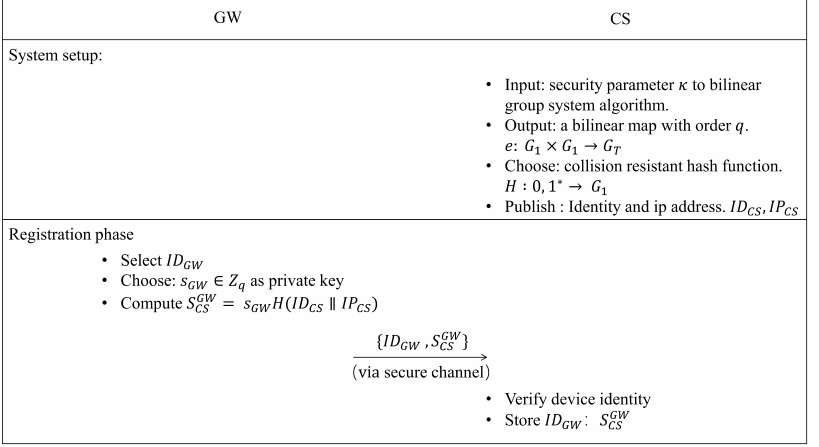
Figure 5. System setup and registration